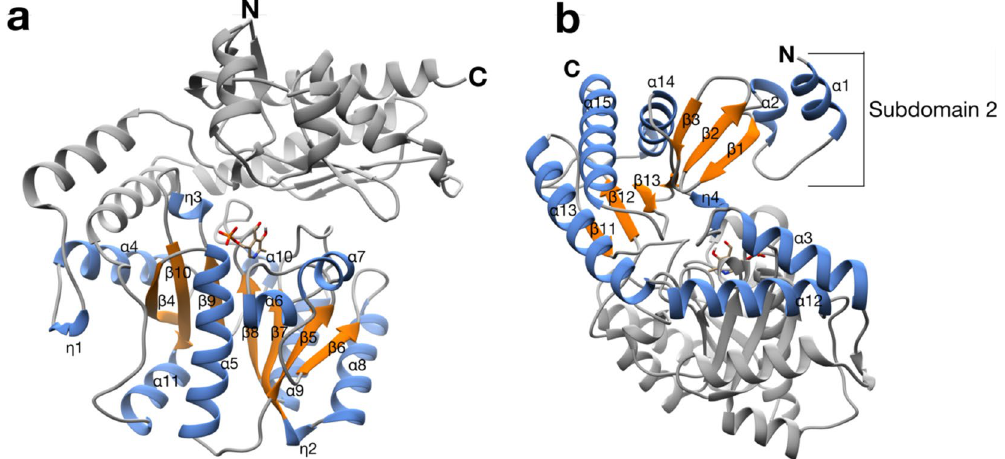
Figure 4. The crystal structure of the Vb TA T16F monomer. Two alternative views of the Vb TA T16F monomer, illustrating the secondary structure organisation of the two domains (cartoon representation). ( a ) the secondary structure elements of domain 1 are highlighted in orange ( α -helices) and blue ( β -strands). PLP bound to the active site is indicated as sticks. For clarity, domain 1 is shaded in grey; ( b ) the secondary structure elements of domain 2 are colored. For clarity, domain 1 is shaded in grey. This figure was generated using Chimera 32